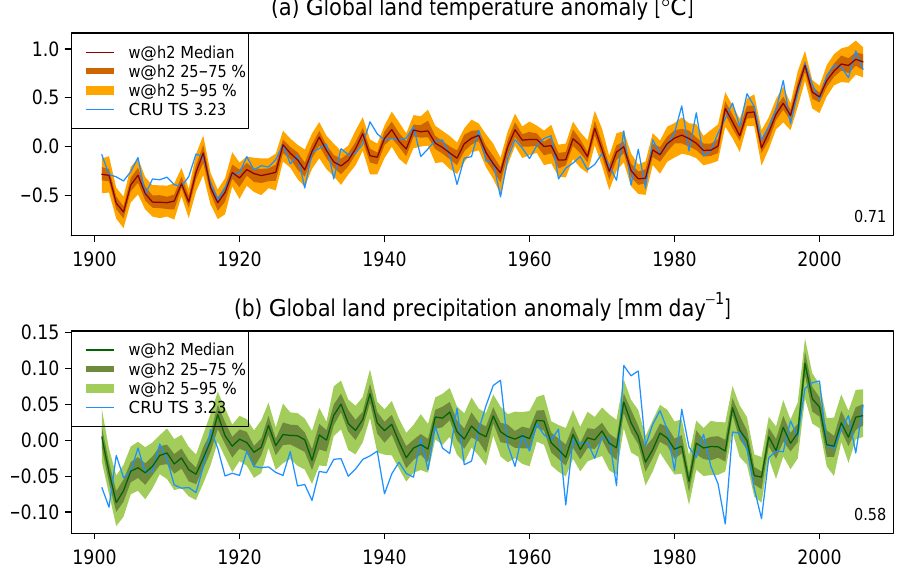
Figure 5. Global land annual mean time series of (a) temperature and (b) precipitation in HadAM3P in w@h2 and CRU-TS, expressed as anomalies relative to 1961–1990. The median, inter-quartile range, and 5–95% range of the w@h2 ensemble members are shown for each year. Antarctica is not included, as in CRU-TS. The fraction of years with observed values lying outside of the 5–95% range of the w@h2 ensemble members is shown in the lower right of each plot. Time series with actual values (i.e. not anomalies) are shown in Supplement Fig.